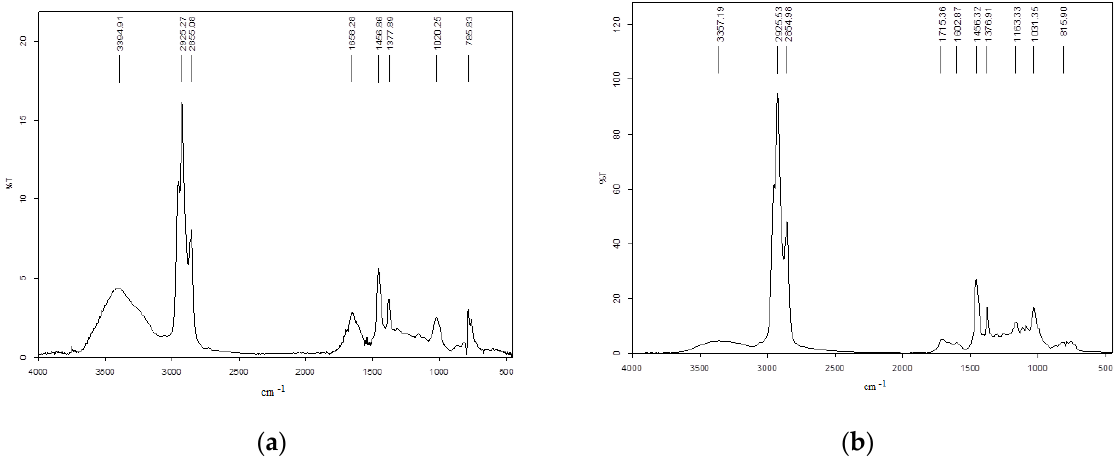
Figure 2. Absorption spectra of DMF extracts of the resins of HO nos. 1 ( а ) and 2 ( b ).